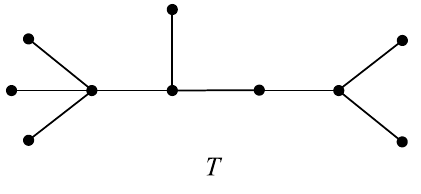
Figure 1. Tree T